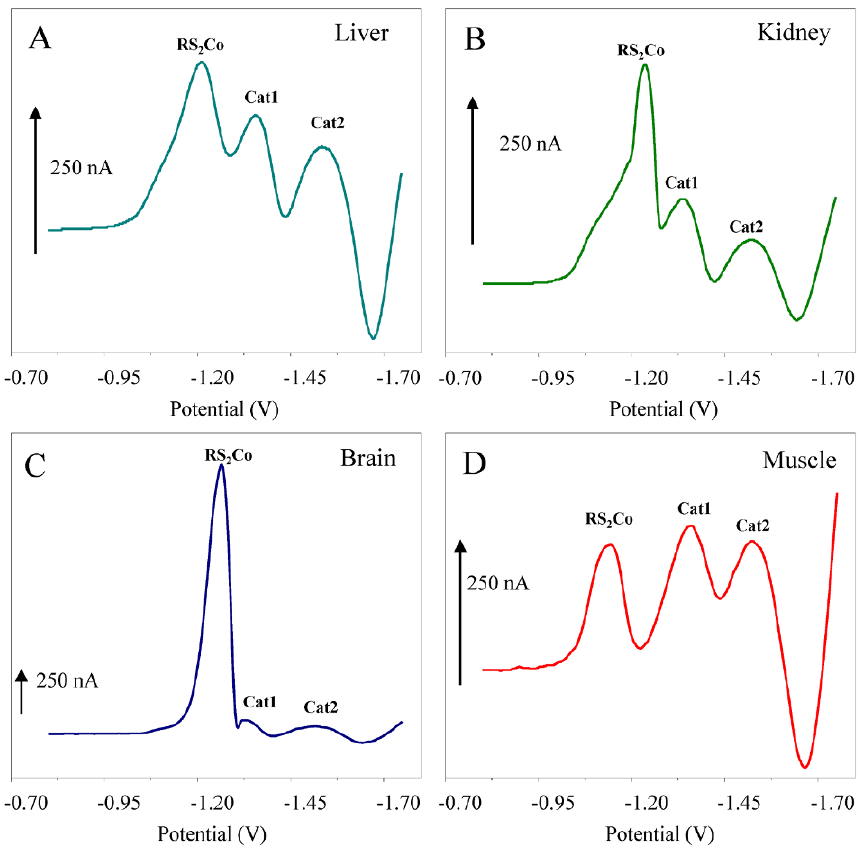
Figure 3. Overlaid voltammetric records of metalothionein in the liver (A), kidney (B), brain (C), muscle (D).